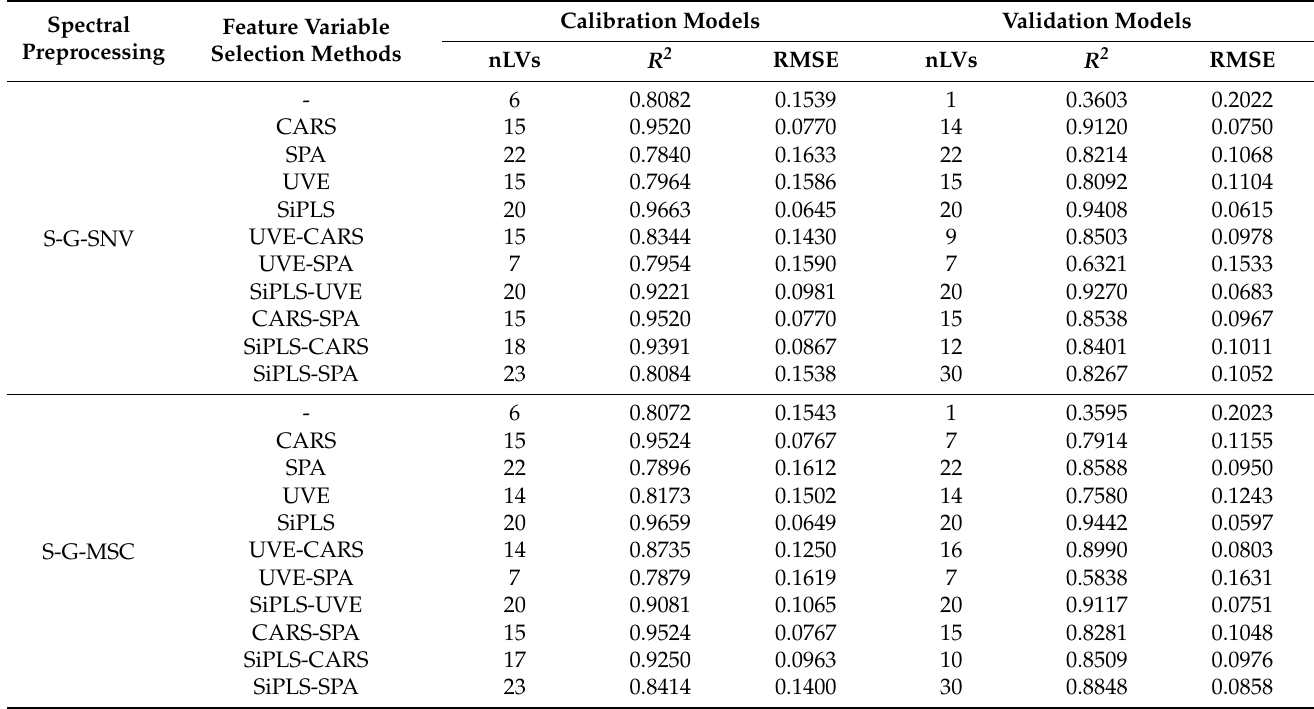
Table 6. PLS modeling results of different variable selection